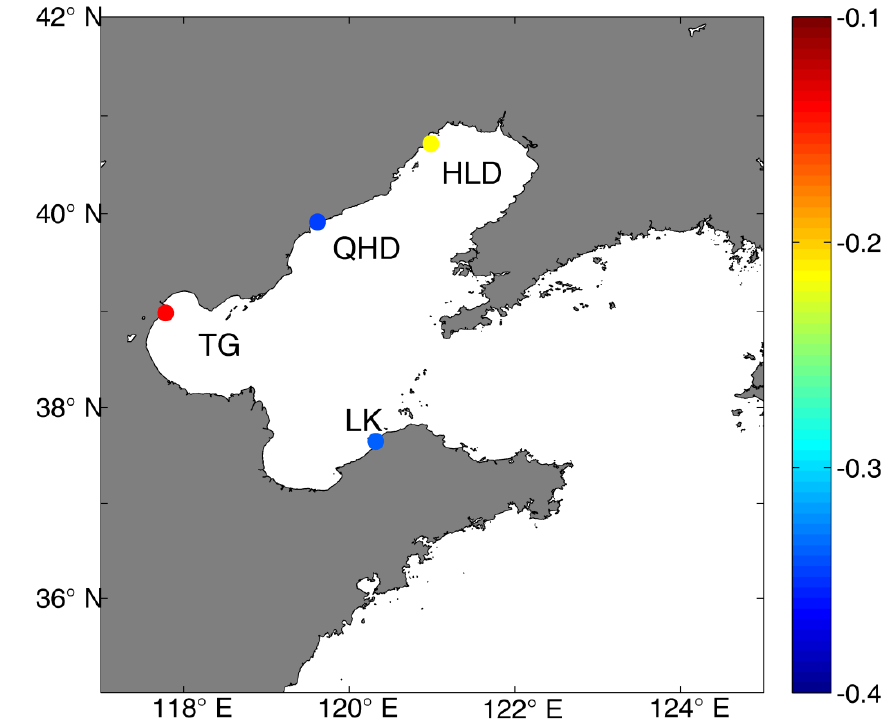
Figure 3. Correlation between the sea level and the PDO at four tide gauges. Atmosphere 2018 , 9 , x FOR PEER REVIEW